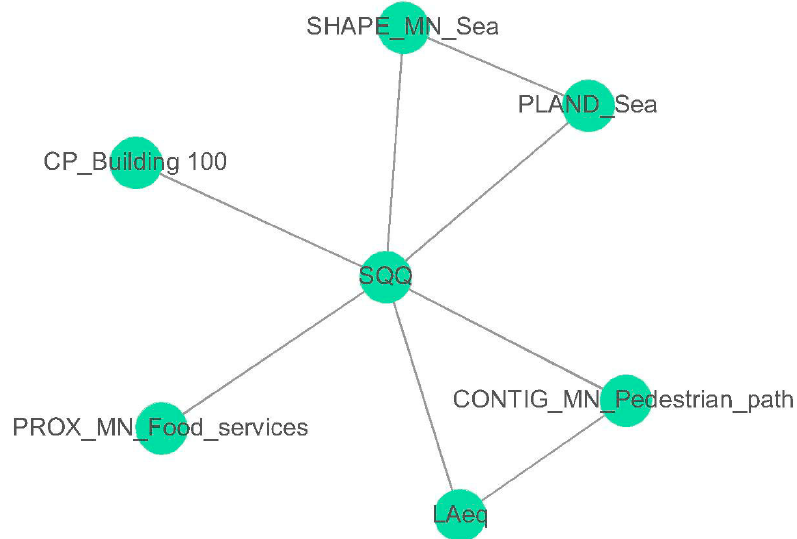
Figure 6. Inferred mRMR network topology of the soundscape quality (SQQ) for the limited road traffic areas. The variables selected were “percentage of generic buildings in the aerial photograph within a distance of 100 m” (CP_Building_100), spatial metric “proximity” calculated for the land use “food services” (PROX_MN_Food_services), spatial metric “contiguity” calculated for the land use “pedestrian path” (CONTIG_MN_Pedestrian_path), spatial metric “percentage of land use” calculated for the land use “sea” (PLAND_Sea), spatial metric “shape” calculated for the land use “sea” (SHAPE_MN_Sea) and A-weighted equivalent sound pressure level (LAeq).